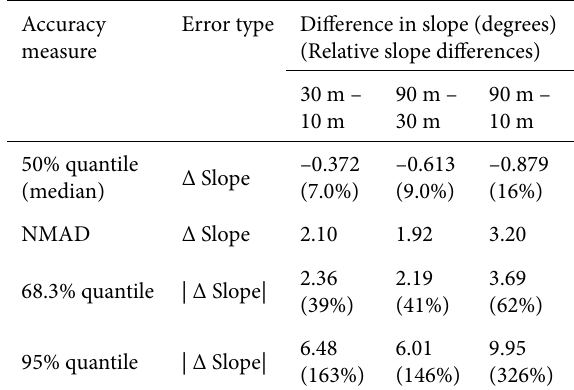
Fig. 6. The frequencies of the differences between the drainage areas estimated by the DEM at three resolutions: 10 m, 30 m and 90 m: A) 90 m – 10